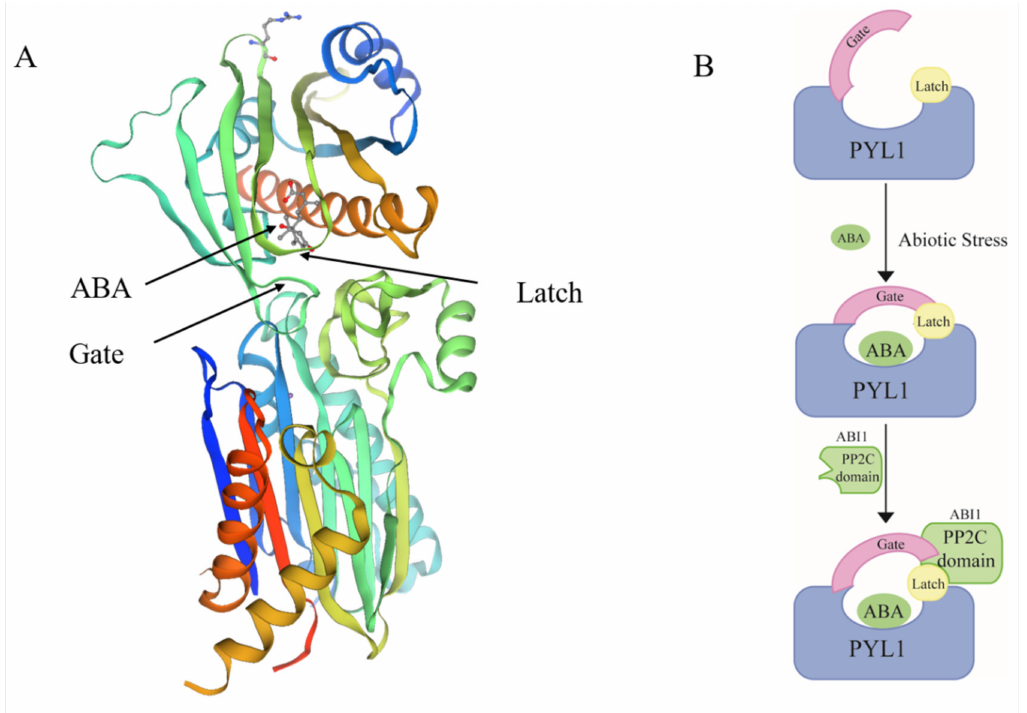
Figure 2. The interaction mechanism of ABA and ABA co-receptors. ( A ) The structure of the PYL1-ABA–ABI1 complex. The model and data come from the website (https://www.sib.swiss/, accessed on 17 November 2021). ( B ) The model of ‘gate’ and ‘latch’. At first, the ABA receptor PYL1 in an open state. When the abiotic stress signal comes, ABA enters the receptor pocket and the gate loop is closed. Then interact with the PP2C domain of ABI1 to inhibit their protein phosphatase activity, causing activation of the SnRK2s-dependent phosphorylation